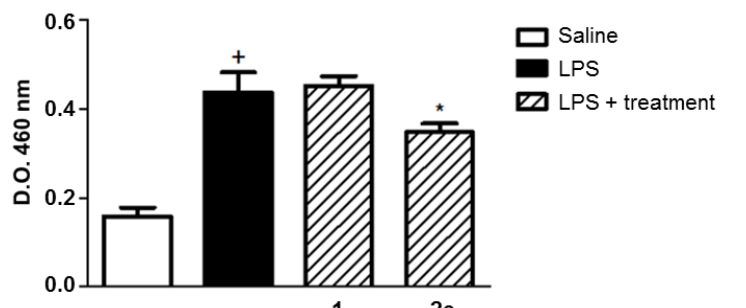
Figure 3. Effect of the phthalimide derivatives 1 and 2e (50 mg/kg; p.o.) on pulmonary neutrophil infiltration in a murine model of acute lung inflammation induced by LPS (25 μ g/animal, i.n.). Values are mean ± SEM from six animals. + p < 0.05 as compared with saline group; * p < 0.05 as compared with the group stimulated with LPS; ANOVA followed by Newman-Keuls Student